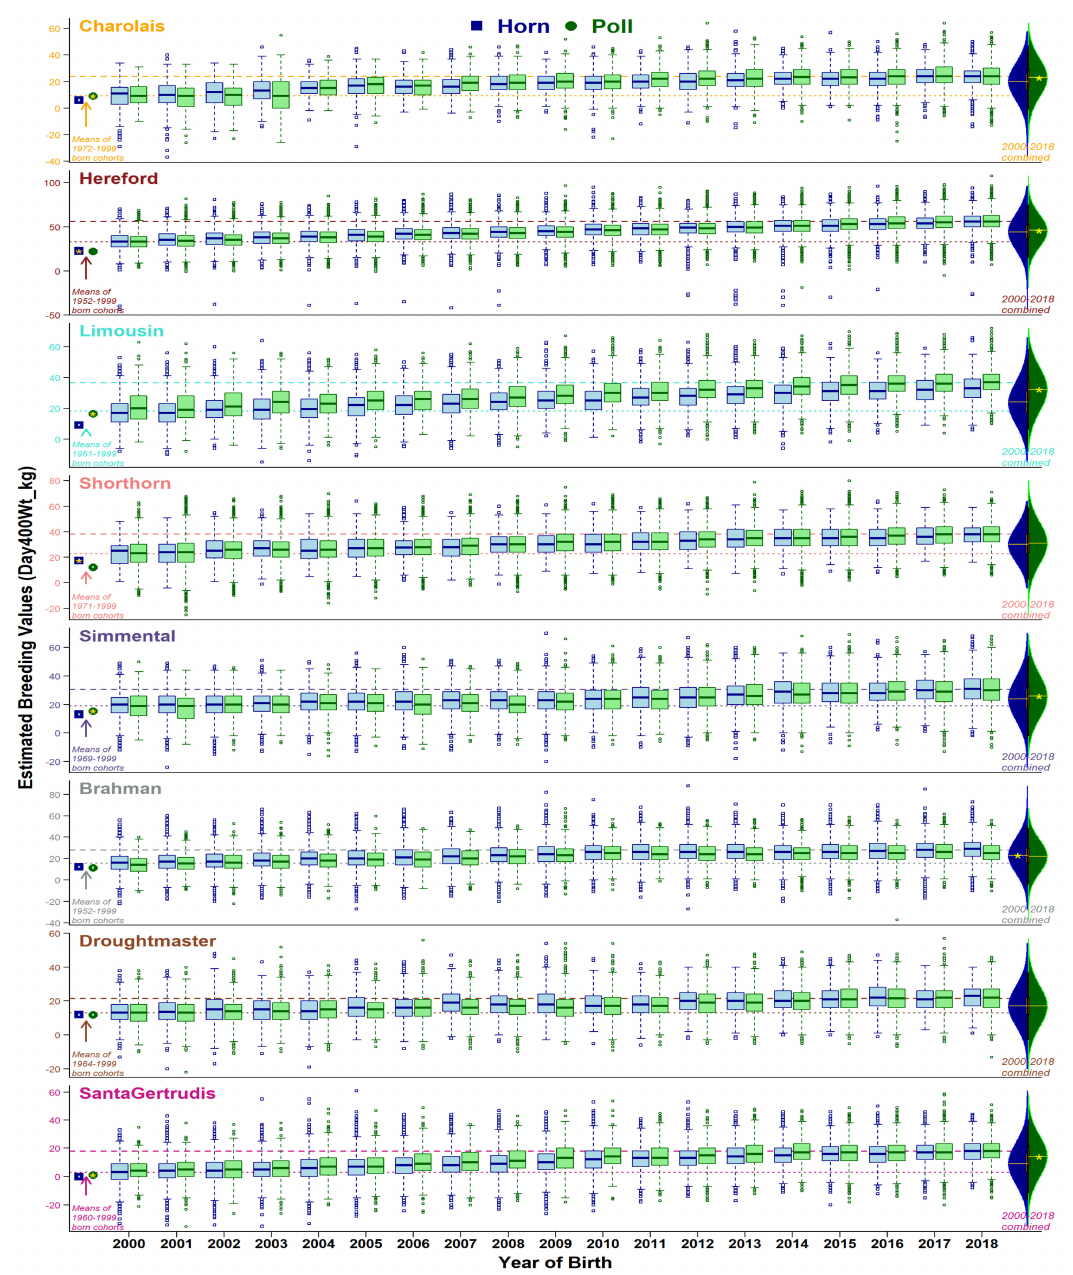
Figure 3. Boxplots of 400 day weight EBVs (accuracy ≥ 50%) for horn (blue) and poll (green) cohorts born from 2000 to 2018. Dotted and dashed lines show breed averages at the start (2000) and end (2018) of the selected period. Points at the left side of graphs show cohort averages for recorded animals born before 2000. On the right-side, violin plots show the distribution of horn and poll cohorts during 2000 to 2018 combined, with a yellow star representing a statistical significance of mean